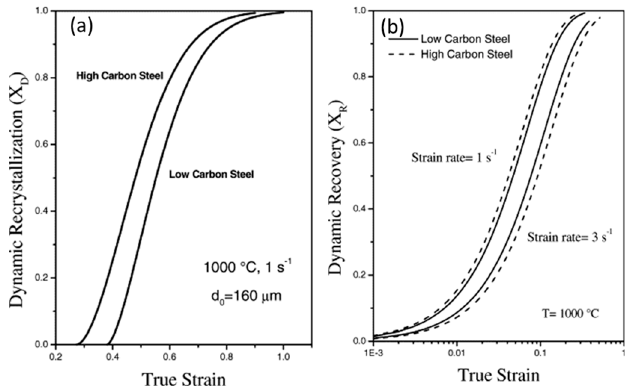
Figure 21. The progress of ( a ) dynamic recrystallization and ( b ) dynamic recovery at 1000 °C [117]